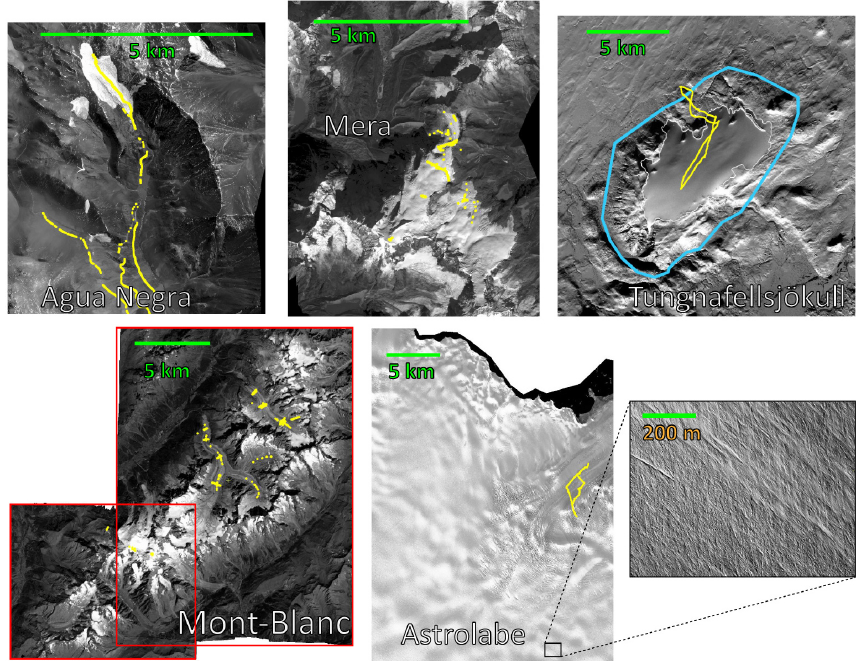
Figure 2. Pléiades orthoimages for the five different study sites. Yellow dots locate the GNSS measurements used to evaluate the DEMs. For Tungnafellsjökull, the blue polygon marks the limits of the lidar DEM. For the Mont-Blanc area, the red rectangles separate two stereo pairs acquired the same day which are combined to cover the entire glacier complex. For Astrolabe Glacier, an enlargement of a 750m by 600m area in the upper part of the glacier (elevation of > 700m above ellipsoid) is